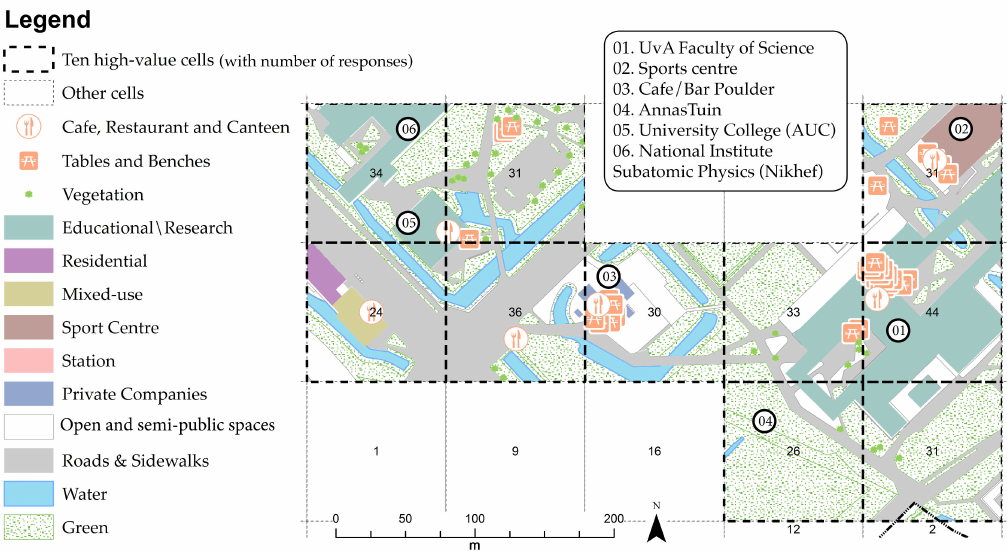
Figure 12. Ten high-value cells at